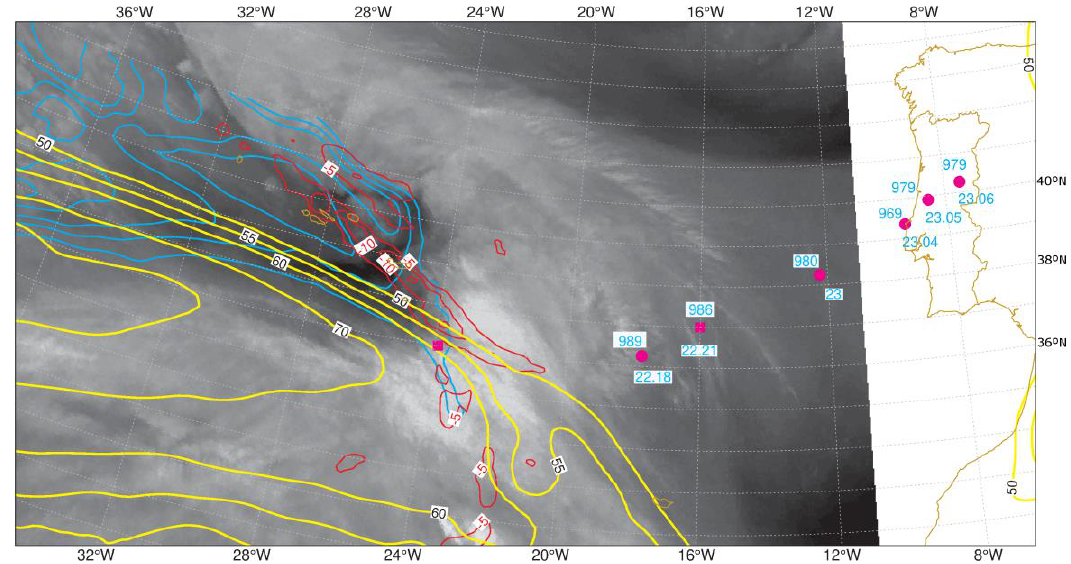
Figure 2. MSG WV6.2 image at 12:00 UTC on 22 December 2009. Wind speed at 300 hPa (50, 55, 60, 70 and 80 m s −1 , yellow lines). Potential vorticity at 300 hPa (1, 1.5, 2, 3 and 4 PVU, 1PVU = 10 −6 m 2 s −1 K kg −1 , cyan lines) and convergence at 850 hPa (−5, −10 and −15 × 10 −5 s −1 , red lines). The Xola trajectory is marked using ECMWF analyses (circles on Atlantic), ASCAT product (square) and MSLP data of IPMA stations (circles over mainland Portugal). The MSLP (in hPa) at the depression center is marked above the symbol, and the day and time are marked below the symbol. The ASCAT estimate of MSLP at the square point was 998 hPa.